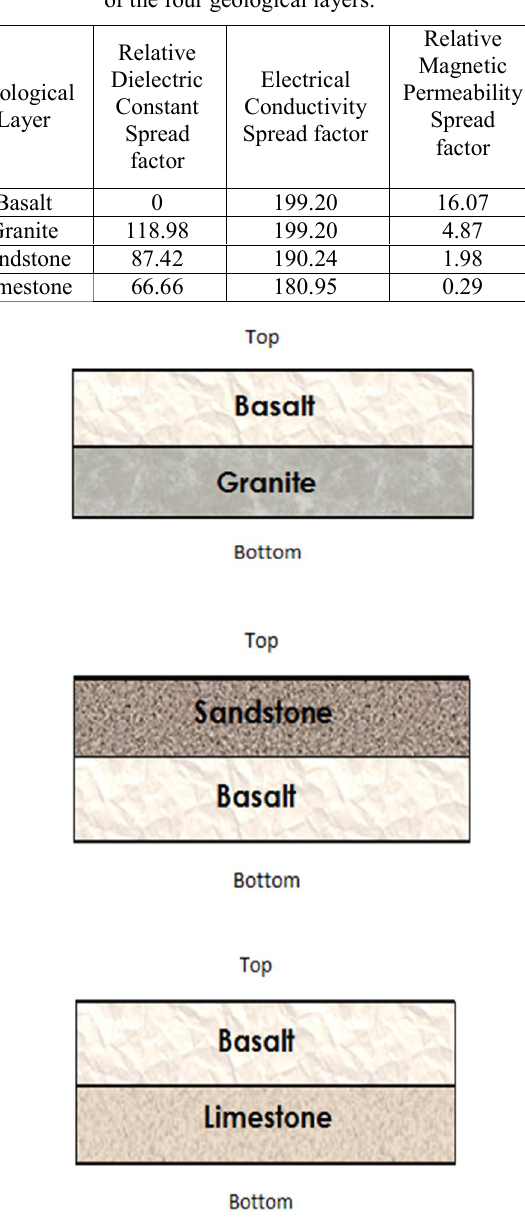
Figure 3: Three horizontal layered models representing Common Geological